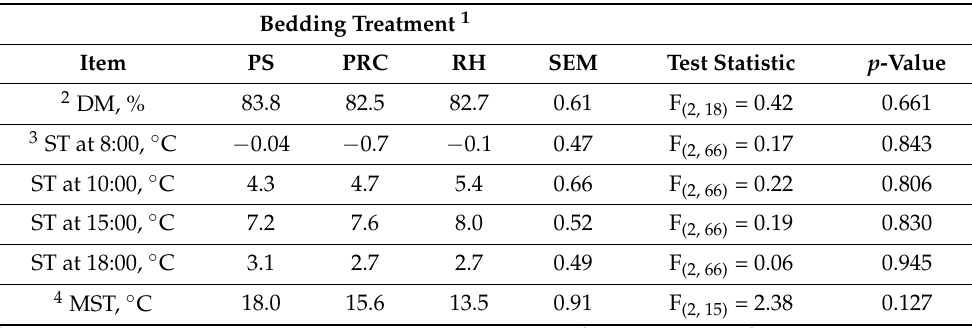
Table 3. Physical properties of peanut shells, a peanut shell–rice husk combination, and rice husks when used as dairy cow bedding treatments.